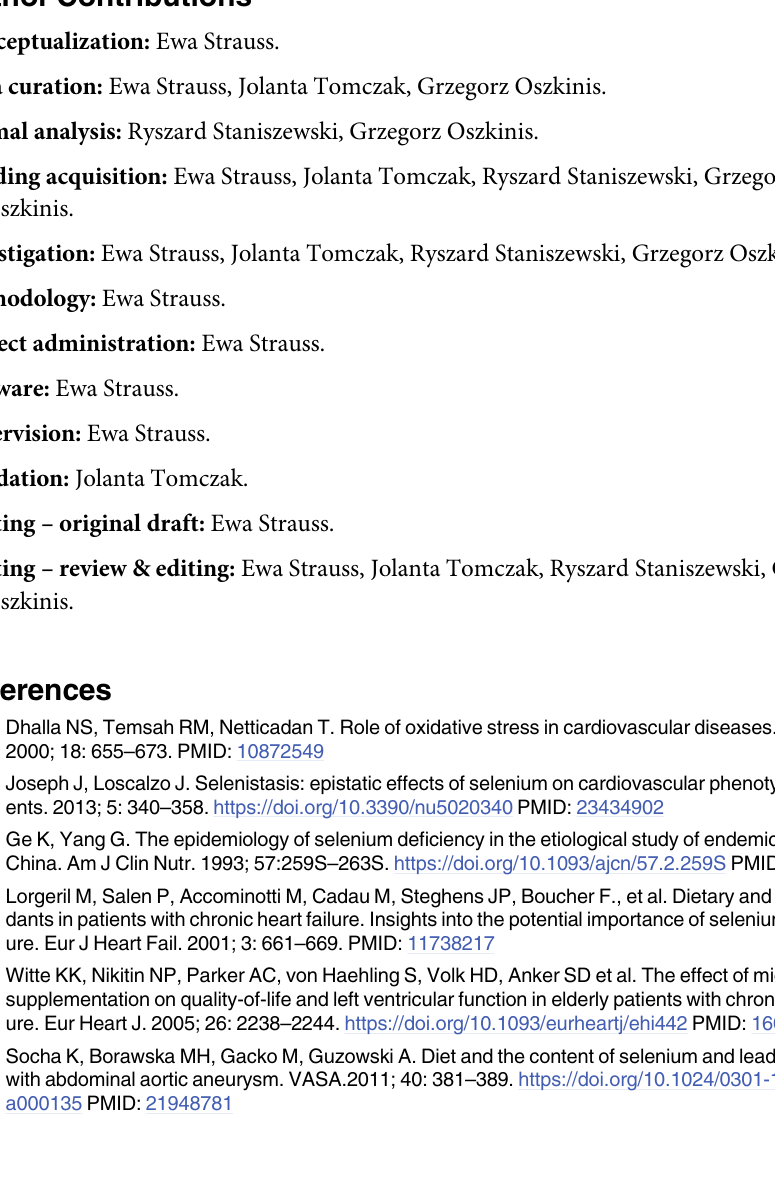
S7 Table. Genotype data set.